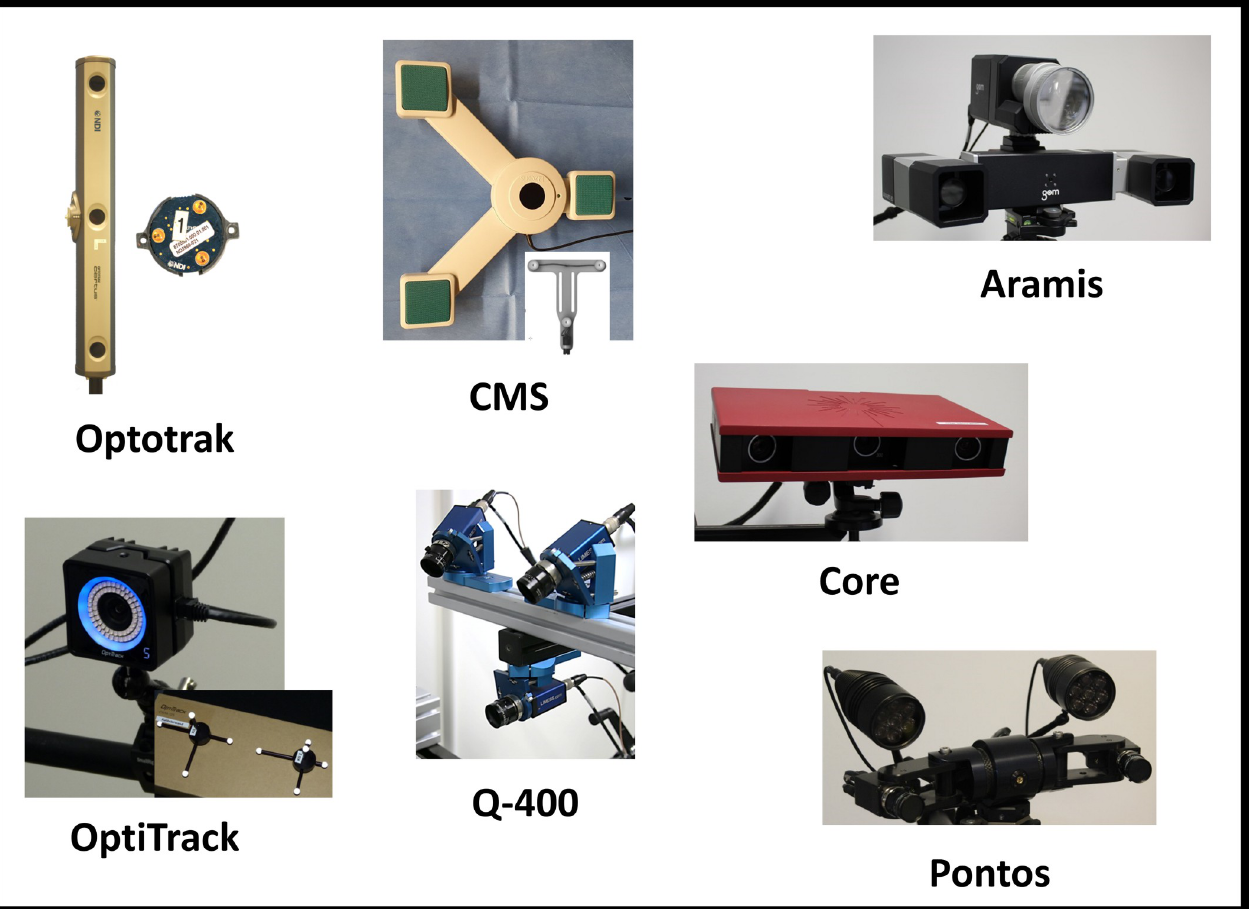
Fig 1. Images of the seven measurement systems used for the accuracy and zero offset measurements.